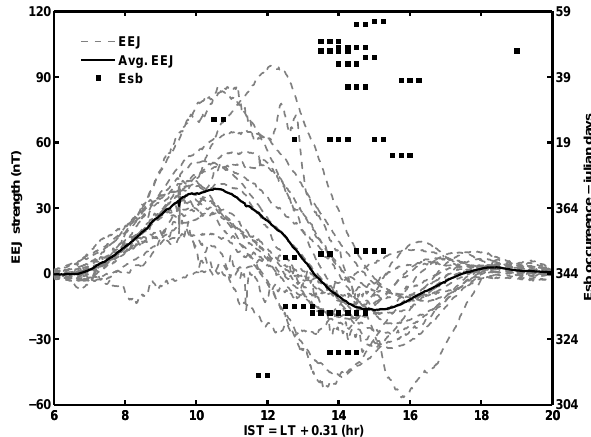
Figure 6. Occurrence of E sb and corresponding EEJ profiles as a function of IST for days under the category I of winter solstice of 2009. The EEJ profiles are represented by broken grey curves. The solid black curve represents the average of all EEJ profiles